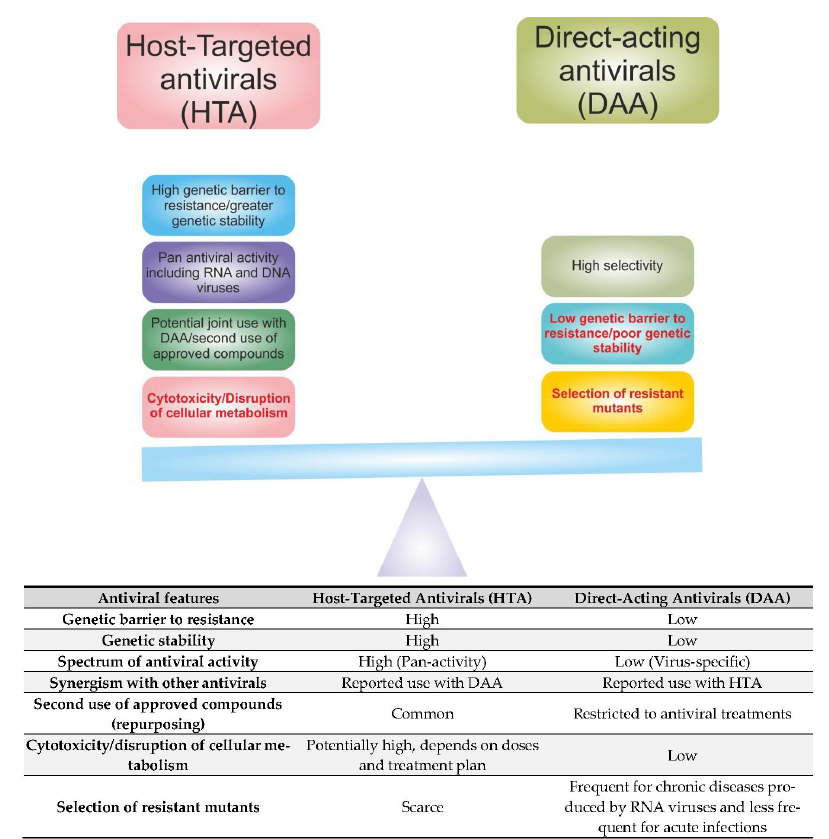
Figure 3. Graphic summary and summary table of the most salient features of HTAs and DAAs. Red text indicates the disadvantages of the indicated approach.